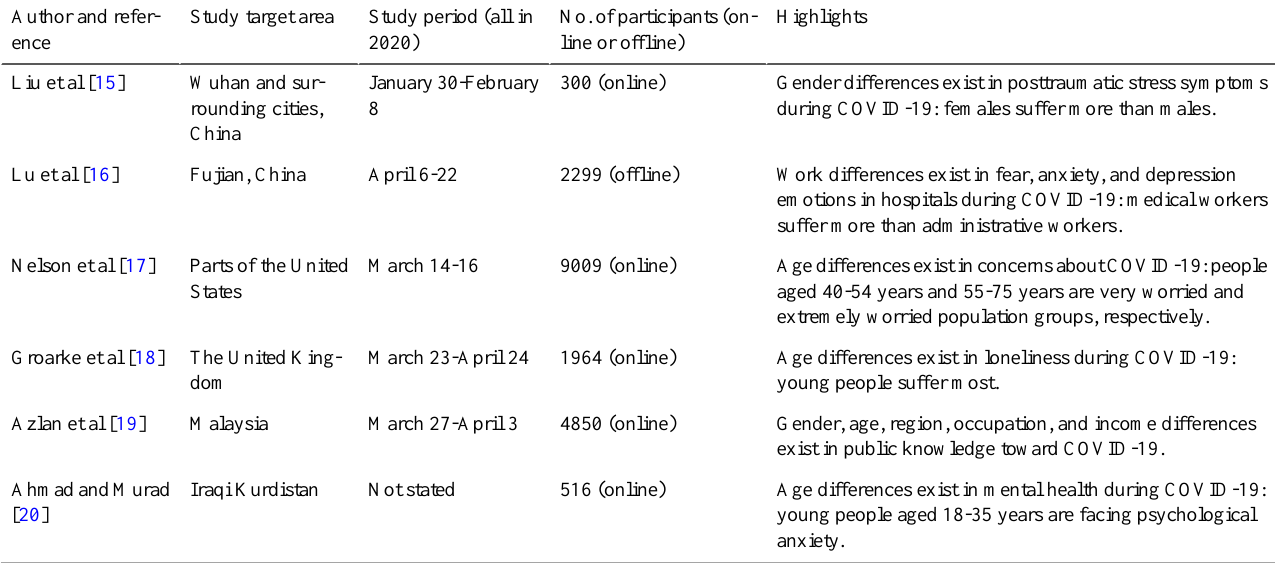
Table 1. Representative cross-sectional studies on COVID-19.